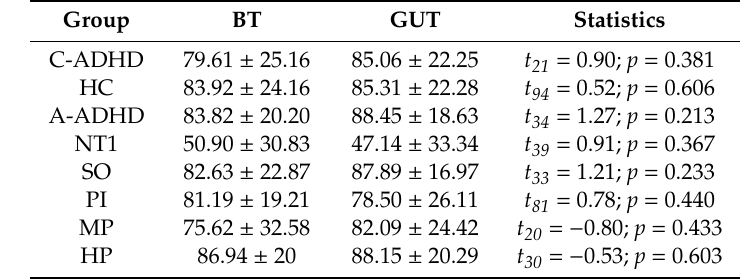
Table 3. Means and standard deviations of prospective memory performance at bedtime (activity 1) and get-up time (activity 2). Although statistical analyses were performed on arcsine-transformed percentages, we chose to report the untransformed percentage values in the table. Statistics are also reported.